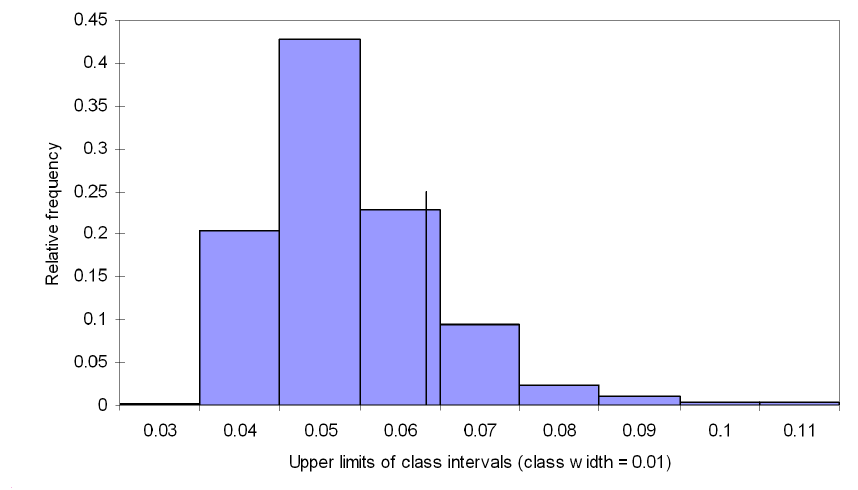
Figure 2: Histogram of largest AIC influence measures obtained in 10 000 bootstrap samples.